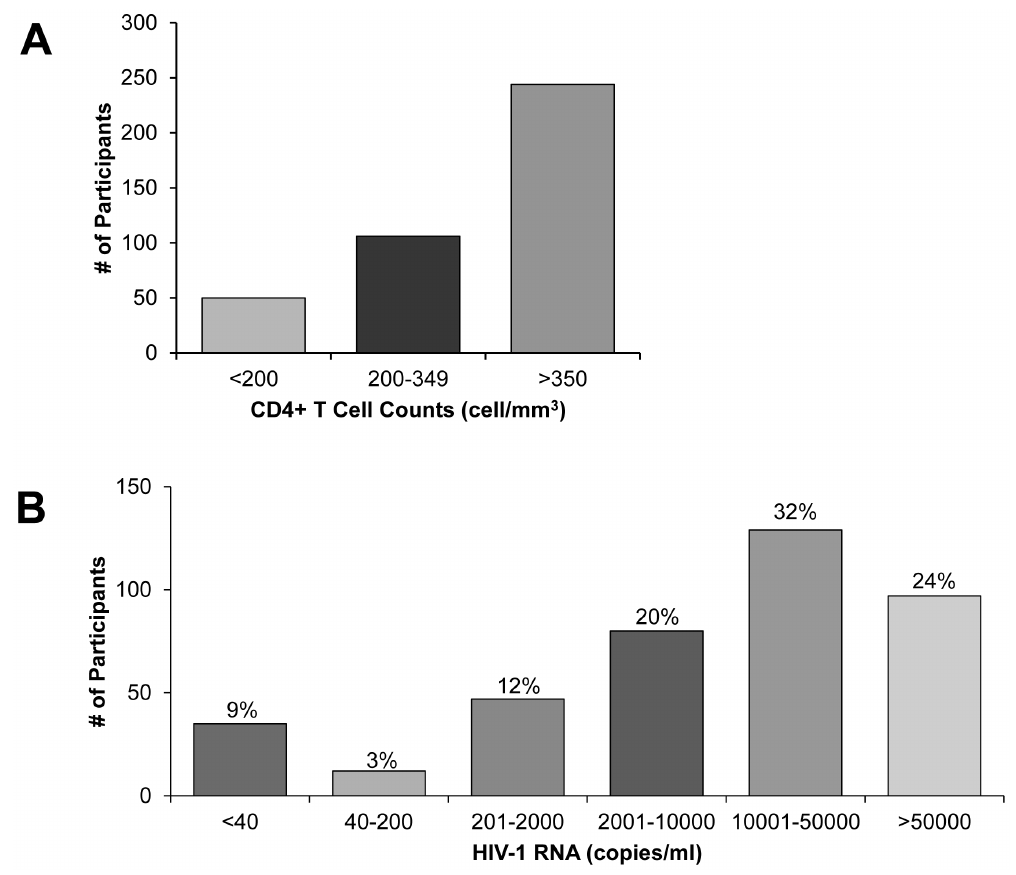
Figure 3. CD4 + T Cell Counts and HIV-1 RNA Levels of HIV-1 Positive Participants. Histogram showing frequency of HIV positive participants (n=400) that have (A) CD4 + T cell counts , 200 cells/mm 3 indicating risk for AIDS, 200–349 cells/mm 3 indicating treatment eligibility, and . 350 cells/mm 3 ; and (B) varying levels of HIV-1 RNA (copies/ml).